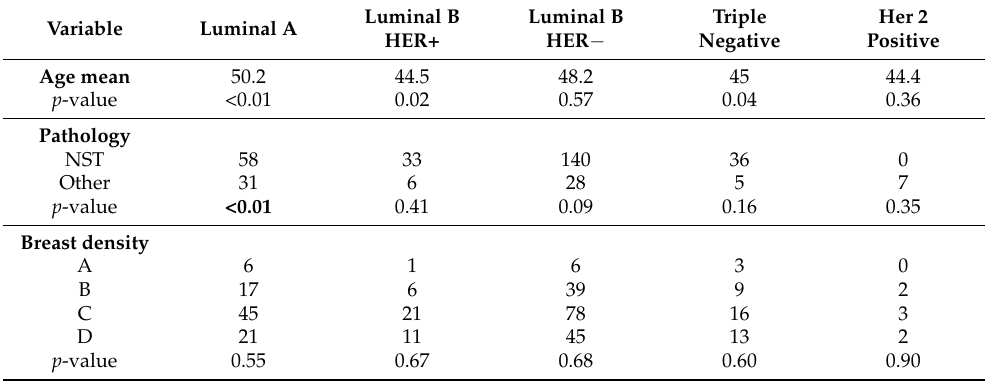
Table 1. Breast cancer molecular subtypes—association between pathology and MRI features. Variable